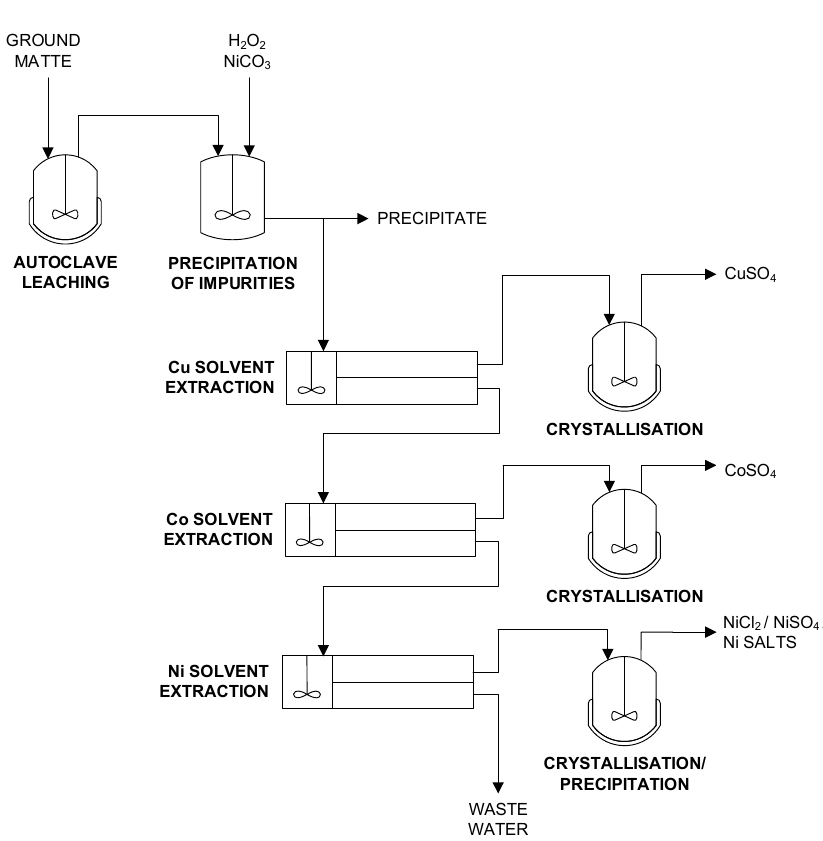
Figure 4. Simplified flowsheet of Nickelhütte Aue GmbH based on [49].